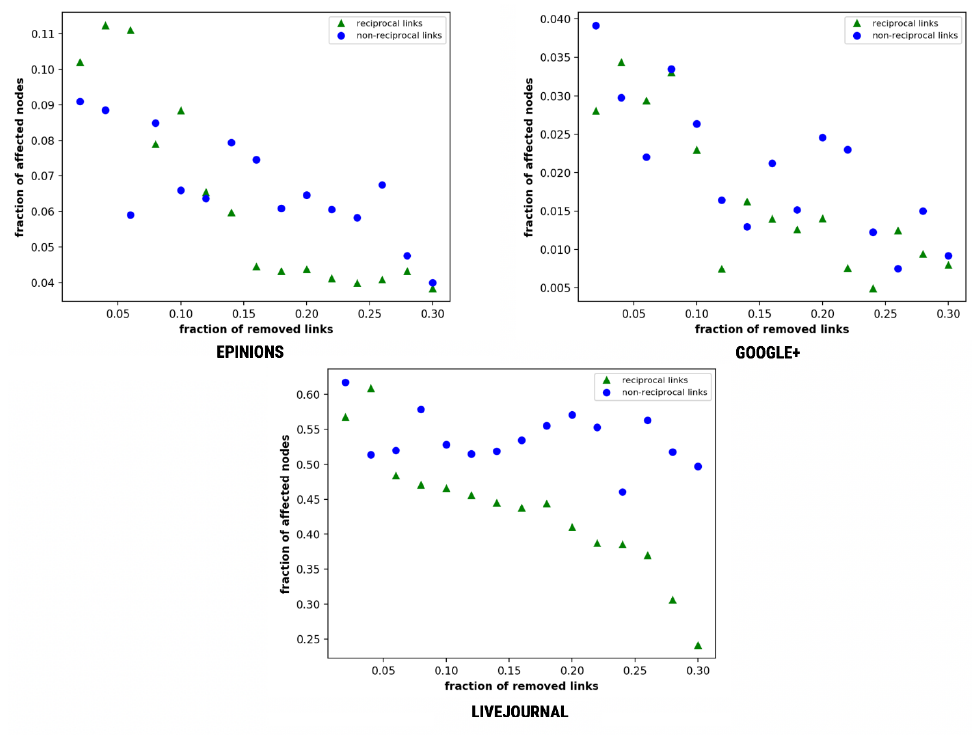
Figure 8. Decay diffusion—fraction of affected nodes as a function of the fraction of removed